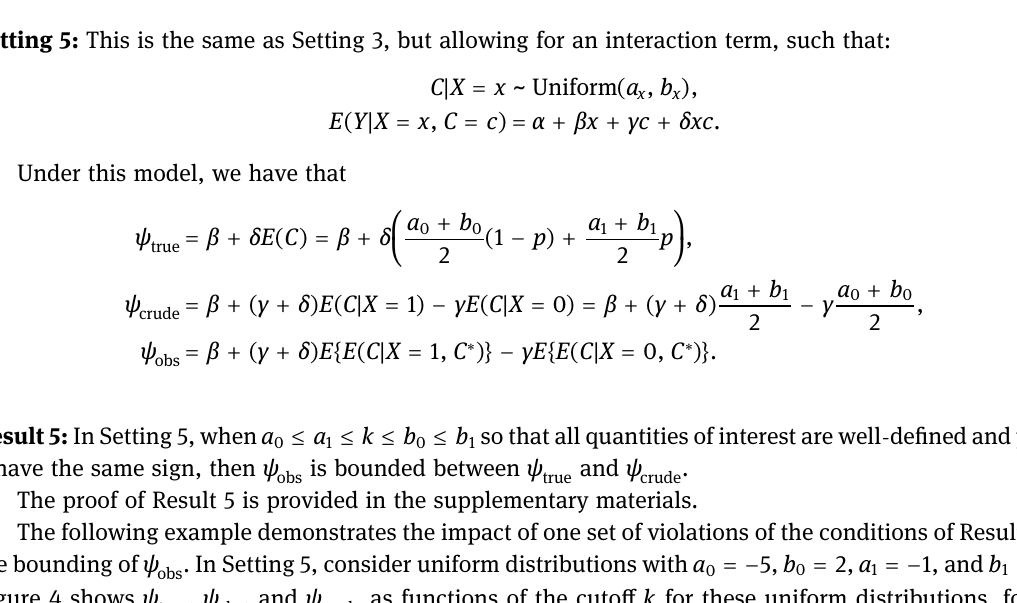
Figure 3: True, observed, and crude e ff ects as functions of the cuto ff k in Setting 4. p 0.6 = , μ −4.5 and δ −2.2 =